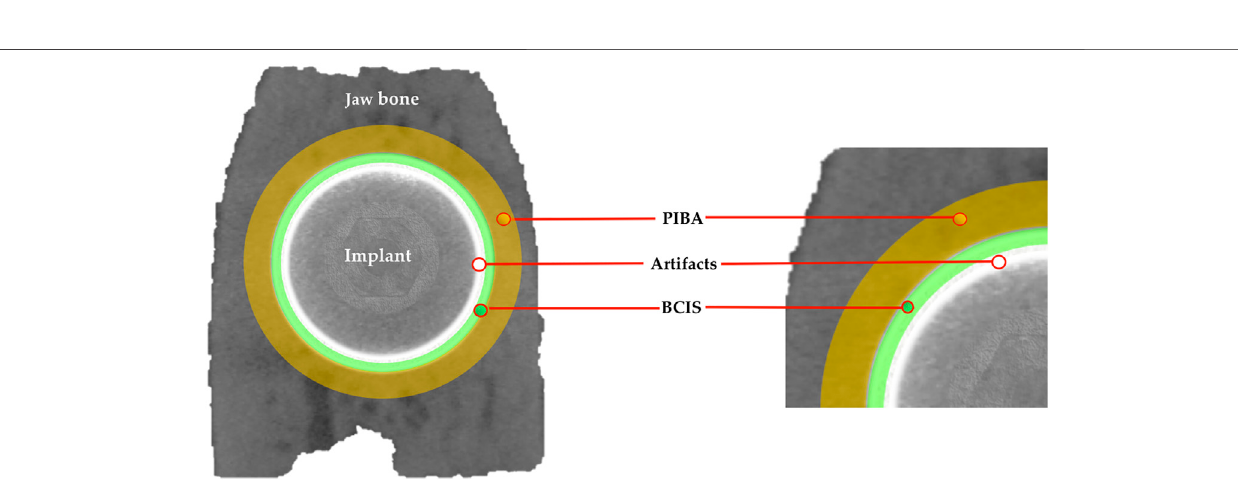
Frontiers in Bioengineering and Biotechnology |